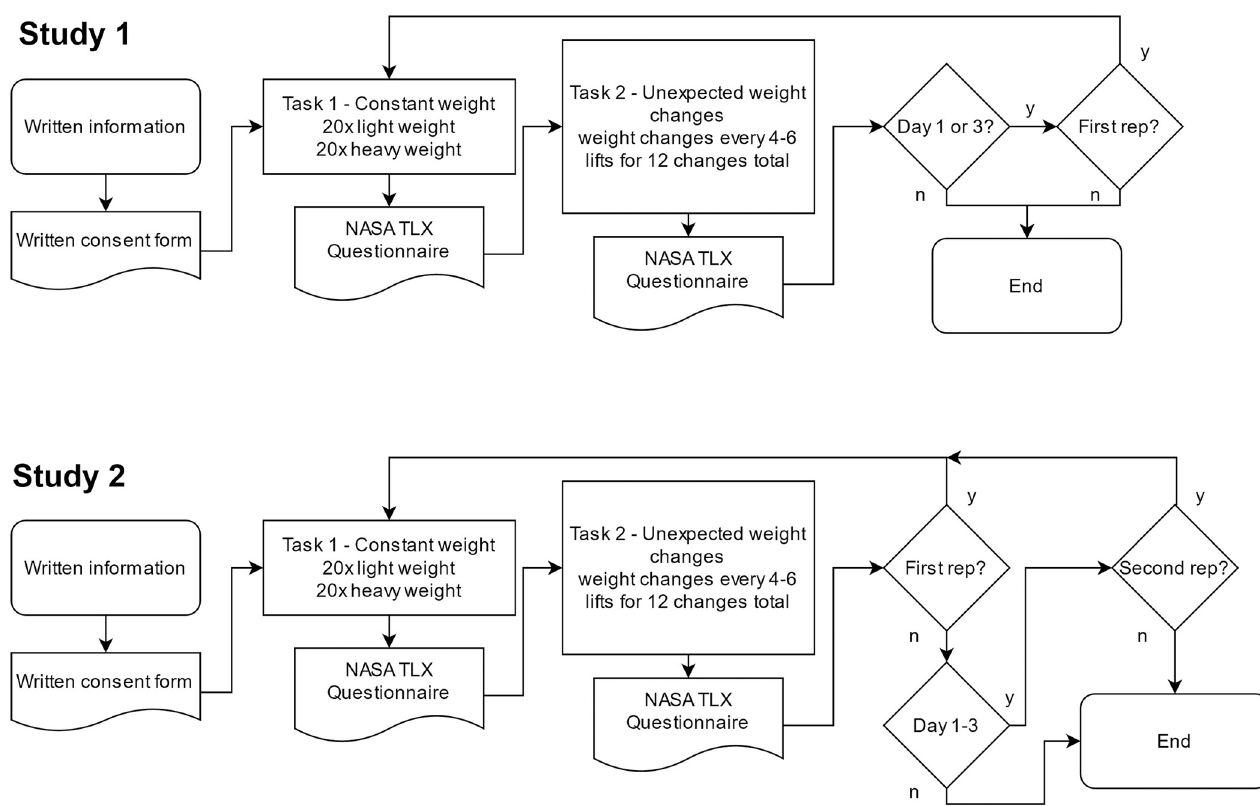
Fig 2. Flowchart of the experimental procedures of Study 1 and 2. In Study 1, participants performed both tasks twice (without and with feedback according to group) on days 1 and 3 but only once (with feedback) on day 2. In Study 2, GN performed the same tasks three times (without, with, and again without feedback) on days 1–3 and only twice (without feedback) on day 4 (control condition). TLX = Task Load Index (including our custom extension of the